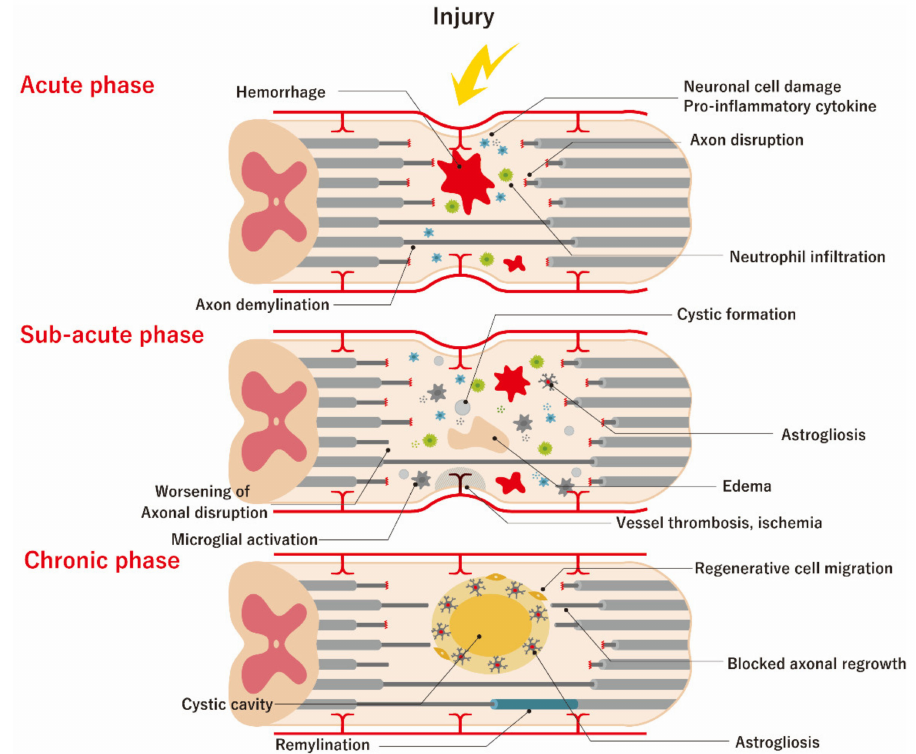
Figure 2. Pathophysiology of spinal cord injury (SCI). Secondary injury can be divided into three phases, which are acute (within a few days), sub-acute (2 days to 6 months), and chronic (over 6 months). During the acute phase, both vascular and cell membrane damage takes place. Vascular damage can cause hemorrhage and blood spinal cord barrier (BSCB) disruption. The mass e ff ect created by massive hemorrhage can additionally damage the surrounding viable tissues. The BSCB draws the rapid infiltration of inflammatory cells such as neutrophils, resulting in the release of various pro-inflammatory cytokines. Damaged and / or necrotic cells release ATP, potassium ions, and DNA into their microenvironment, which can activate microglia to release additional proinflammatory cytokines and induce the recruitment of more peripheral inflammatory cells. During the sub-acute phase, arterial vessel damage compromises the vascular supply, which can aggravate ischemic damage to the surviving neuronal cells; meanwhile, edema caused by the alteration of vascular membrane permeability leads to further neuronal and vascular damage. Inflammatory cytokines are released from resident and blood-derived cells, and glutamate is released from damaged neuronal cells. The failure of the astrocytic re-uptake of these damage-associated molecular-pattern molecules (DAMPs) can further compromise the neuronal network, resulting in a worsening of demyelination. Inflammatory cytokines can upregulate astrocytes into the active state of astrogliosis, causing them to migrate to the damaged area to isolate it from una ff ected areas; this can be considered as a physiological rescue process. In the chronic phase of SCI, the loss of cell volume leads to the vacuo formation of cystic micro-cavitation which is also called as syringomyelia, and this coalesce and forms a barrier for cell migration and regeneration of axon regrowth. In reactive astrogliosis, astrocytes secrete inhibitory chondroitin sulfate proteoglycans, which are initially protective in blocking the DAMPs from spreading, but which eventually interfere with the regeneration and extension of the neuronal network. On the other hand, low-gear reorganization also commences in the chronic phase, including vascular remodeling, alterations in the extracellular matrix composition, regenerative cell migration, and re-organization of neural